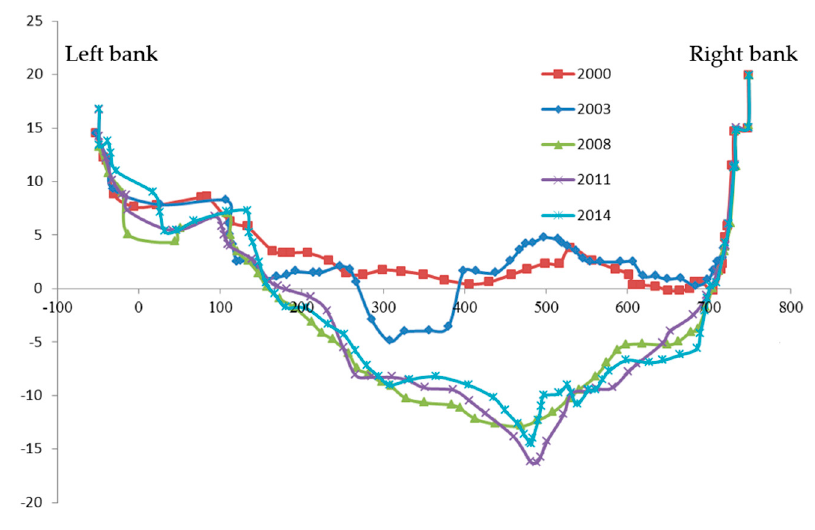
Figure 8. River bed elevation at the cross-section of the Min River at Zhuqi in different